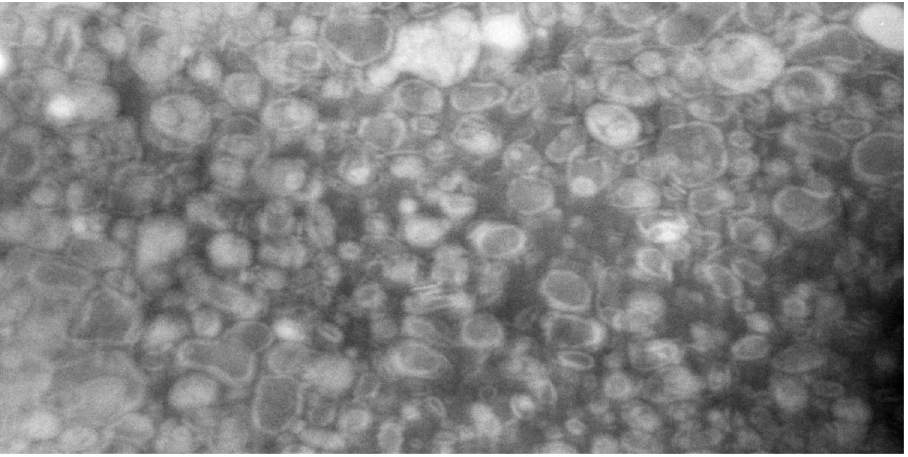
Fig 4. The transmission electron microscopy (TEM) image of nanoliposomes composed of soy lecithin.